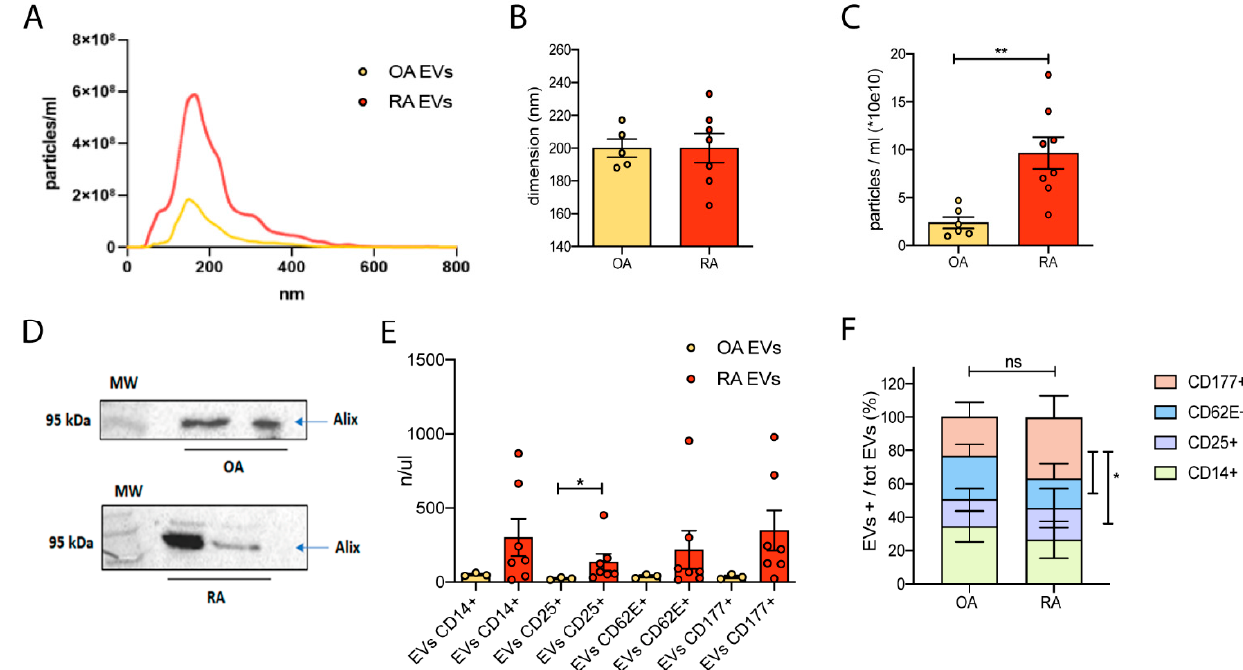
Figure 1. Characterization of synovial fluid-derived extracellular vesicles. ( A ) Representative NanoSight graph: dimension (nm) on x-axis, particles concentration (particles/mL) on y-axis; EVs derived from OA- and RA-synovial fluid are characterized by the same dimension, but a higher RA-particles concentration is obtained from the extraction. ( B ) No difference was observed in the dimension of EVs extracted both from OA- and RA-synovial fluid. ( C ) RA-EVs are characterized by a higher concentration in comparison to OA-EVs. Mann–Whitney test, ** p < 0.01. ( D ) Western Blot analysis revealed the presence of Alix in OA- and RA-EVs pellet. ( E ) FACs analysis revealed that OA- and RA-EVs display similar cellular origin; a significant enrichment of CD25-positive EVs was found in RA-derived vesicles, confirming the higher inflammatory cellular component present in synovial fluid collected from RA patients. Mann–Whitney test, * p < 0.05. ( F ) EVs originated from distinct cellular populations (CD14 + , CD25 + , CD62 +, and CD177 + cells) and expressed as % of total EVs collected from RA or OA synovial fluids. Two-Way ANOVA (Mixed Model) followed by Tukey’s multiple comparisons test, * p < 0.05.